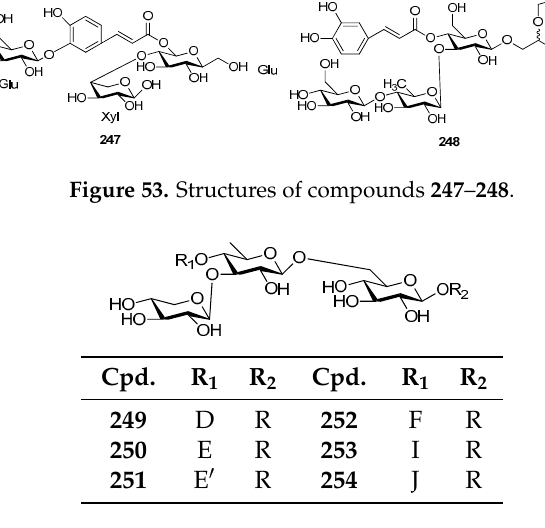
Molecules 2016 , 21 , 1402